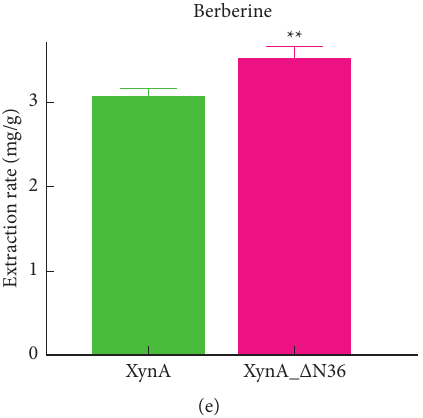
Figure 4: Biochemical analysis of XynA_ Δ N36 and comparison of natural medicinal herb extraction for wild type and truncation. (a) Chromatogram of XynA_ Δ N36 purified using a Hitrap QHP (1 mL) column. UV absorptions at 254nm and 280nm are coloured red and blue, respectively. In addition, the peak for XynA_ Δ N36 is labelled. The black line represents ionic strength. (b) 12% SDS-PAGE analysis of purified XynA_ Δ N36 protein. (c) Chromatogram of XynA_ Δ N36 and XynA analysed using Superdex 200 increase 10/300GL. XynA_ Δ N36 and XynA are coloured blue and black, respectively. (d) Comparison of XynA and XynA_ Δ N36 for salvianic acid A extraction. (e) Comparison of XynA and XynA_ Δ N36 for berberine. XynA and XynA_ Δ N36 are coloured green and pink, respectively. The Y -axis shows the berberine extraction efficiency (mg/g) with different enzymes. The data represent the mean ± S.D. ( n � 3). ∗ p < 0 . 05, ∗∗ p < 0 .